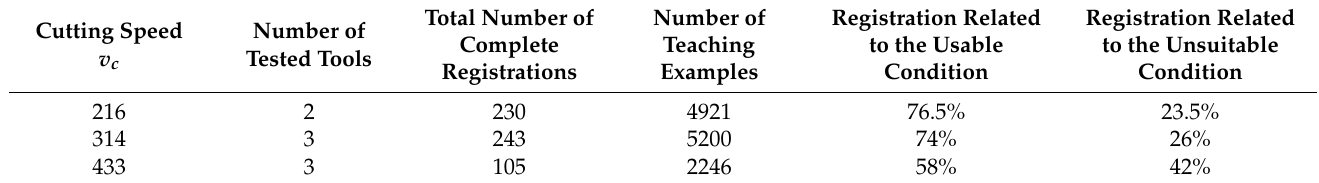
Table 2. Summary of registration and participation of each state class.